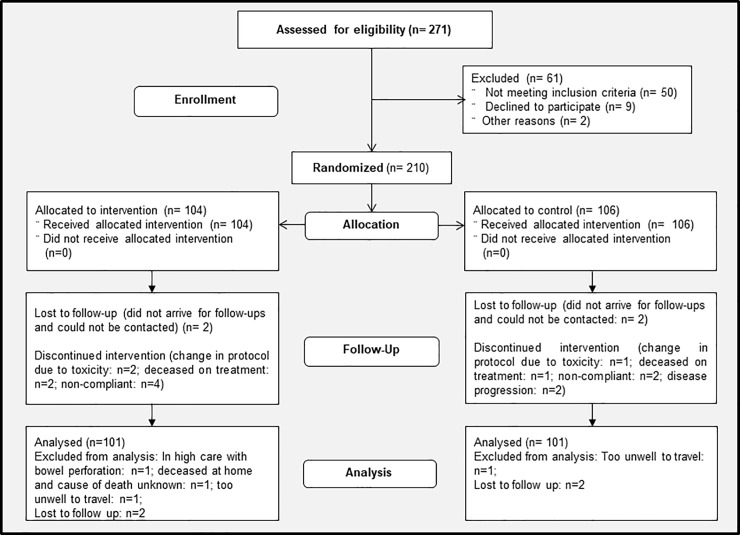
Trial profile: Consort flow diagram.Abbreviations: mEHT: Modulated Electro-Hyperthermia; LDFS: Local Disease Free Survival.